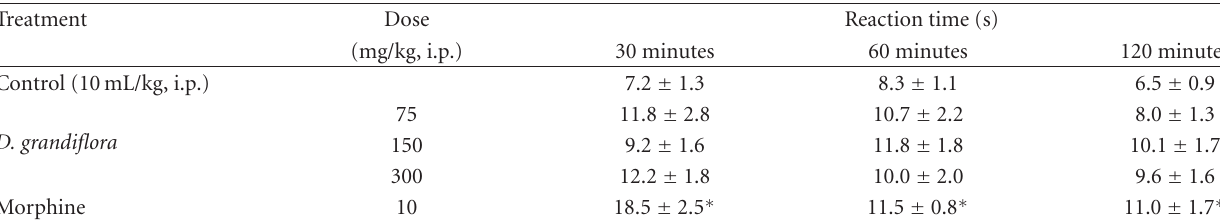
Table 3: E ff ect of EDgP on the hot plate test in mice.